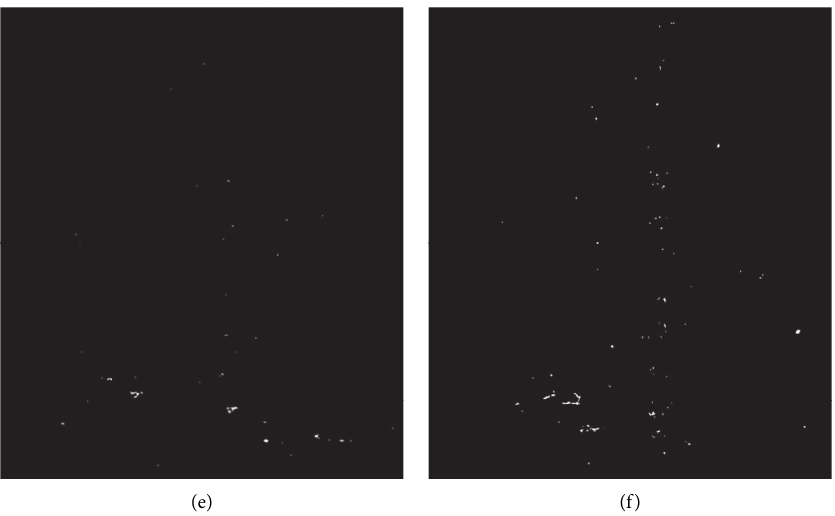
Figure 8: The effect of decision tree classifier. (a) Original image. (b) Segmentation. (c) Longitudinal crack classification image. (d) Transverse crack classification image. (e) Block crack classification image. (f)